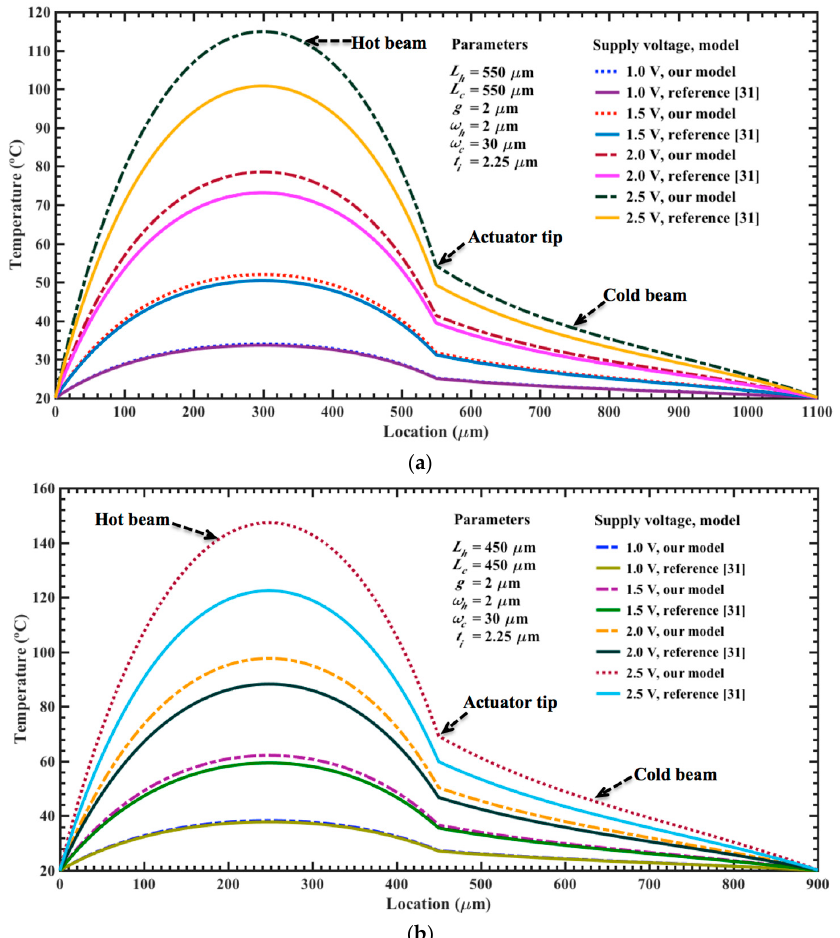
Figure 8. Distribution of the temperature along of the upper (hot) and bottom (cold) beams of two electrothermal actuators with lengths of ( a ) 550 μ m and ( b ) 450 μ m. This temperature is due to different bias voltages, whose values change from 0.5 to 2.5 V.